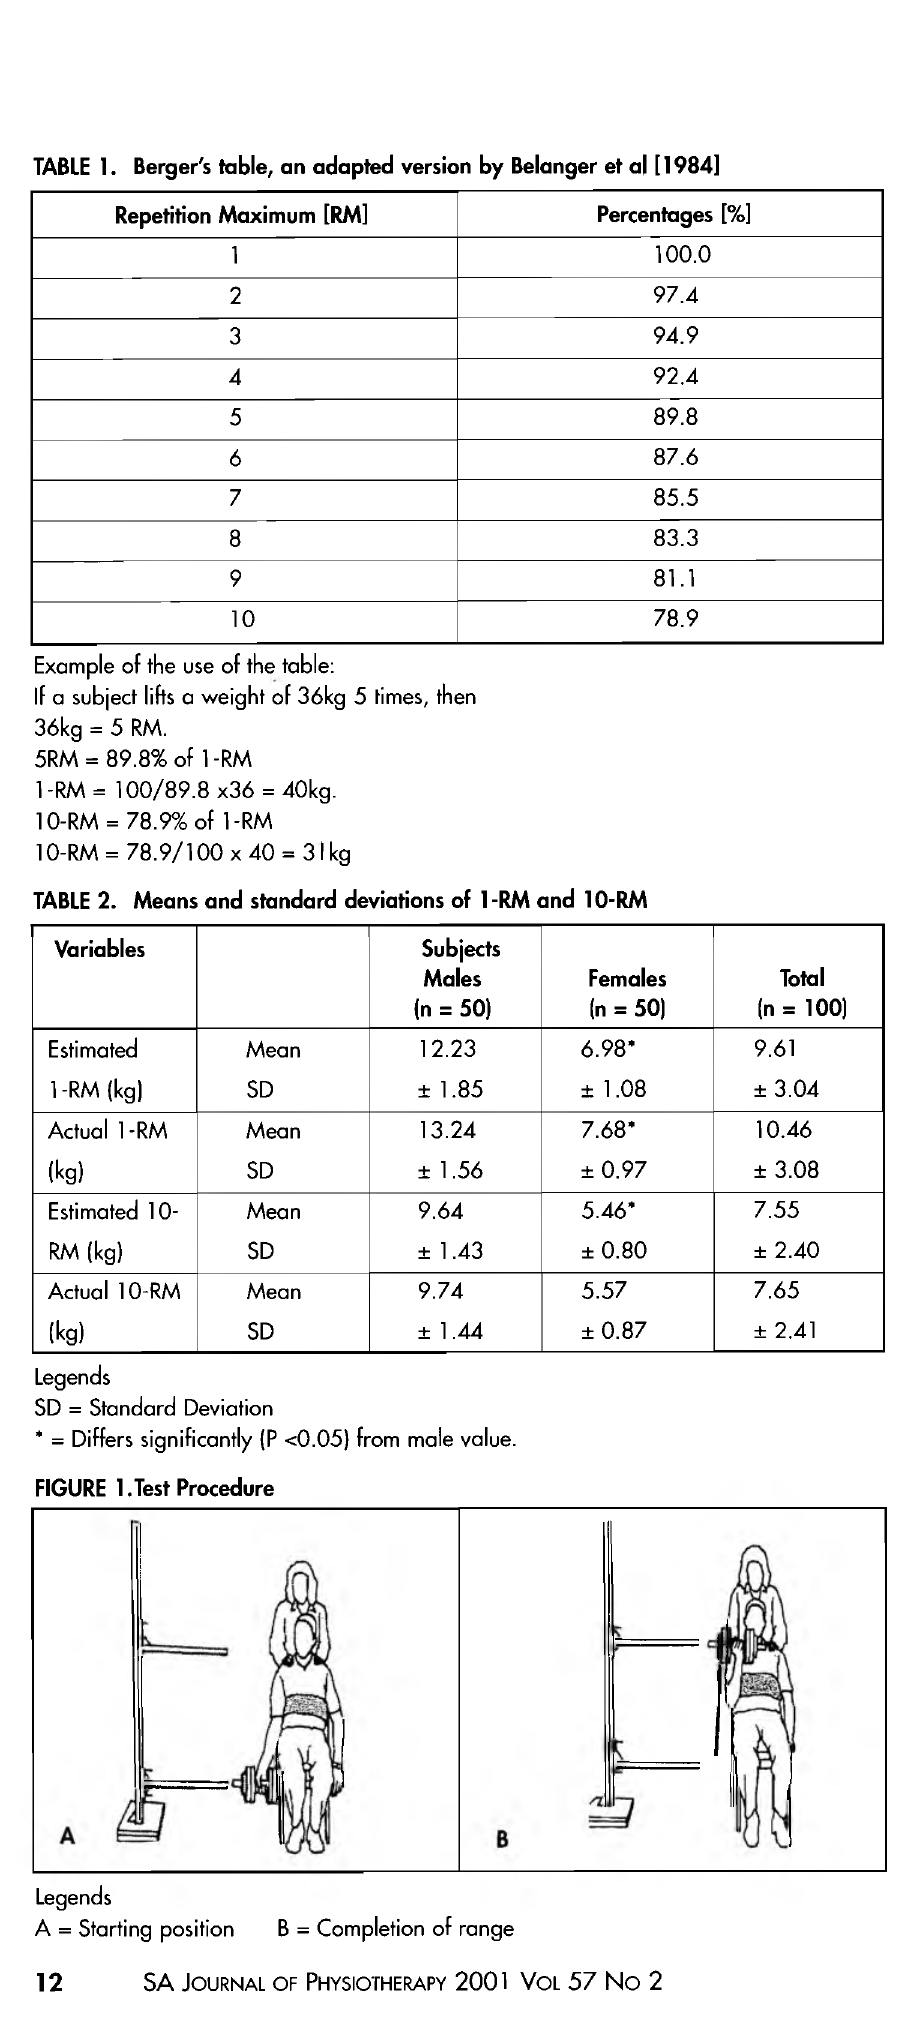
TABLE 1. Berger's table, an adapted version by Belanger et a| [1984]